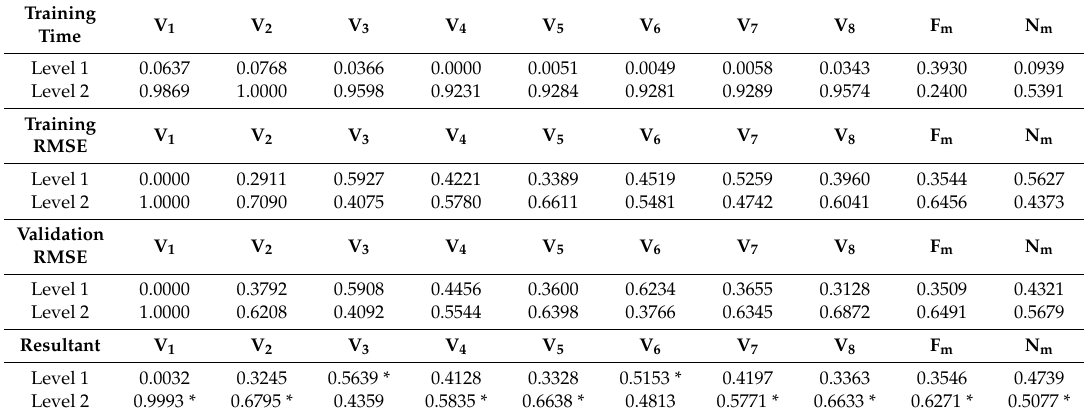
Table 5. Weight normalization and combination for electricity consumption forecasting.